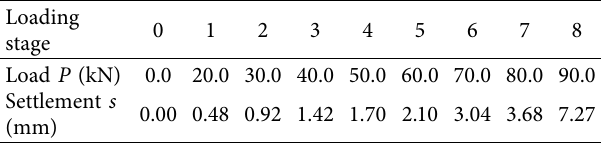
Table 6: Data of the large-scale model test [33].